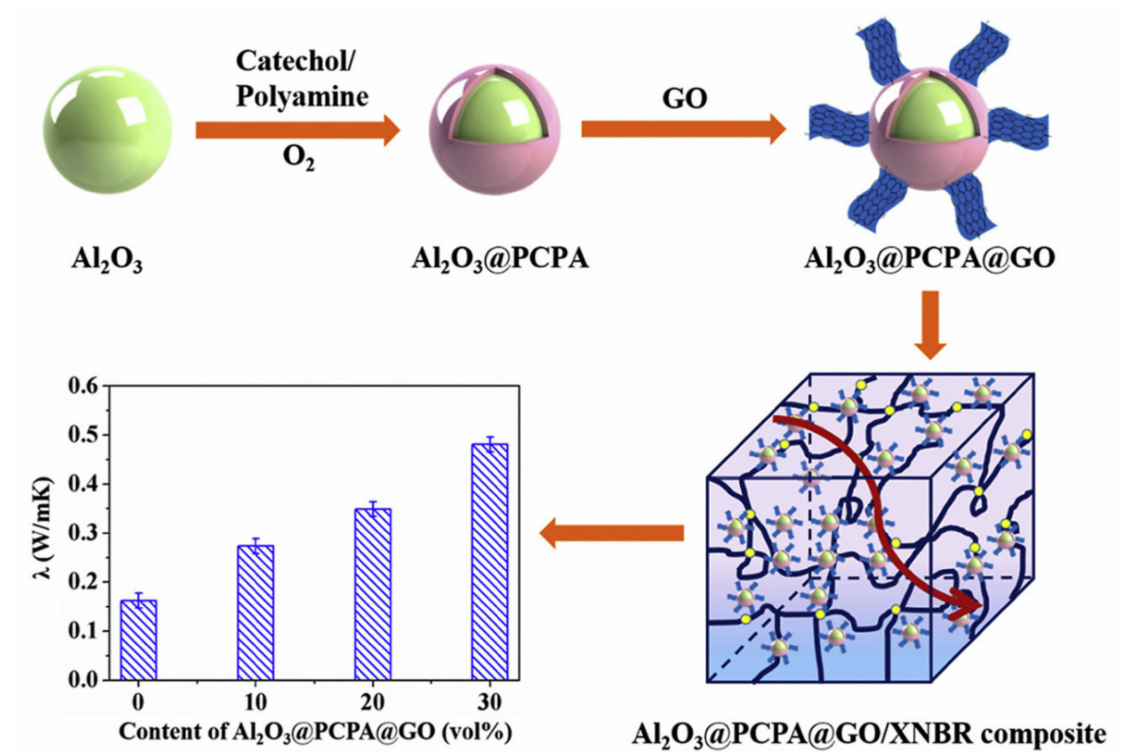
Figure 22. Schematic representation of preparation procedure, thermal dissipation/transfer model, and thermal conductivity properties of Al 2 O 3 @PCPA@GO/XNBR composites [205]. Copyright© 2020 Published by Elsevier Ltd. All rights